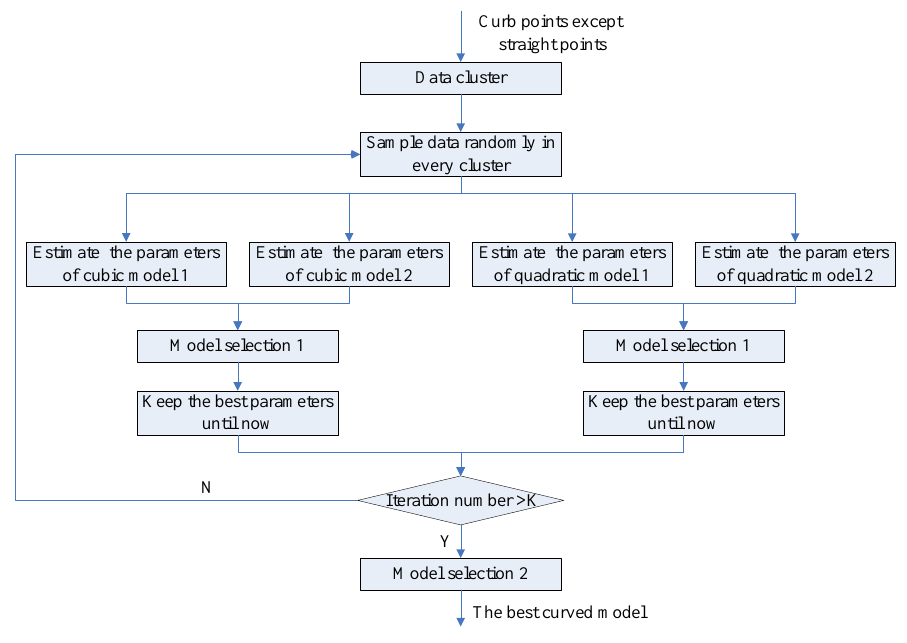
Figure 7. The flowchart of the multi-model RANSAC